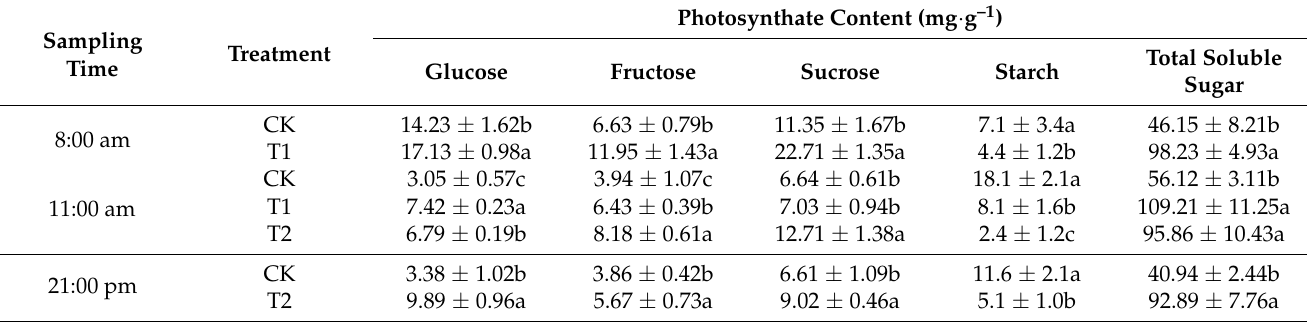
Table 2. Photosynthates in tomato leaves exposed to different LED light supplementation